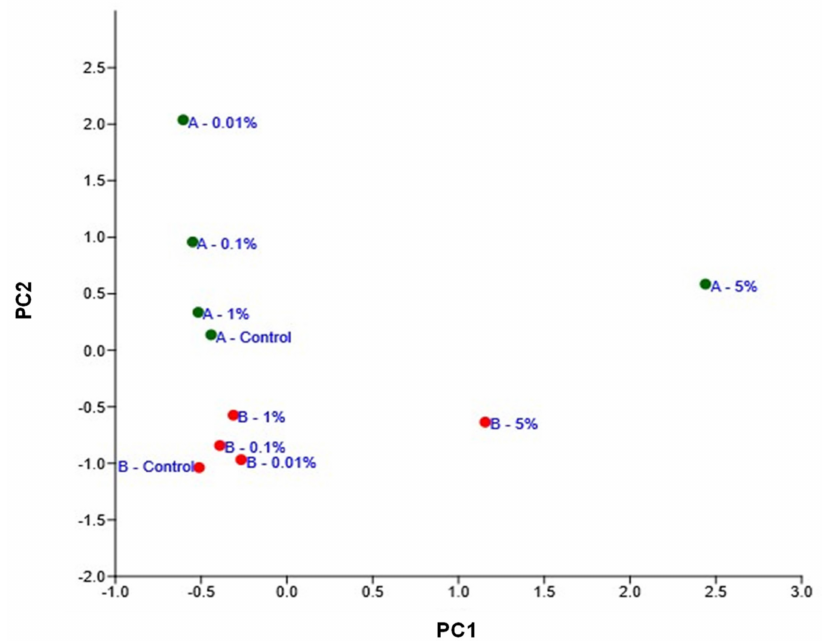
Figure 6. Principal component analysis (PCA) of microbial communities obtained from spiked and control samples from both soils. PC1 eigen value 1.46 (87%); PC2 eigen value 1.08